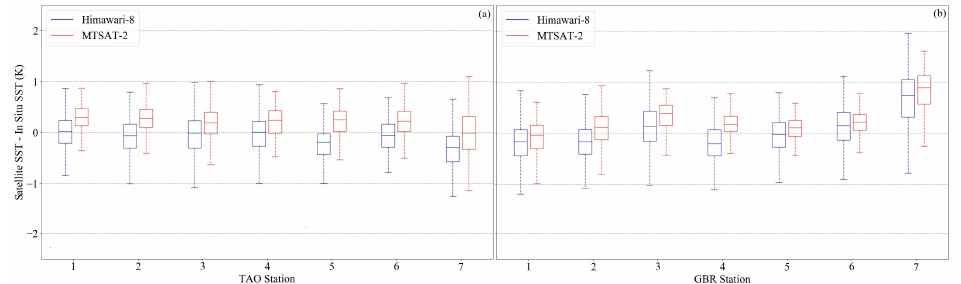
Figure 5. Box plots of the differences between satellite and in situ temperatures for day (blue) and night (red). The top row ( a , b ) is for MTSAT-2 SSTs, and the bottom row ( c , d ) for Himawari-8. The left column ( a , c ) is for the TAO moorings and the right column ( b , d ) for the GBR stations. Outliers are not shown.